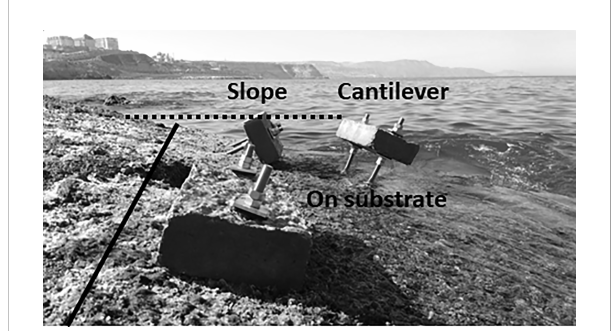
FIGURE 2 Arti fi cial Inert Mobile Substrates (AIMS) used for translocating individuals of Patella ferruginea . The three different treatments considered are shown: on substrate, slope, and cantilever. The solid line indicates the lower limit of the habitat of Patella ferruginea just above the macroalgal turf (note that deployed AIMS were installed out of the habitat of Patella ferruginea ). The dashed line indicates the corresponding tidal level of the AIMS surface that relied on the tidal height where the habitat of Patella ferruginea is